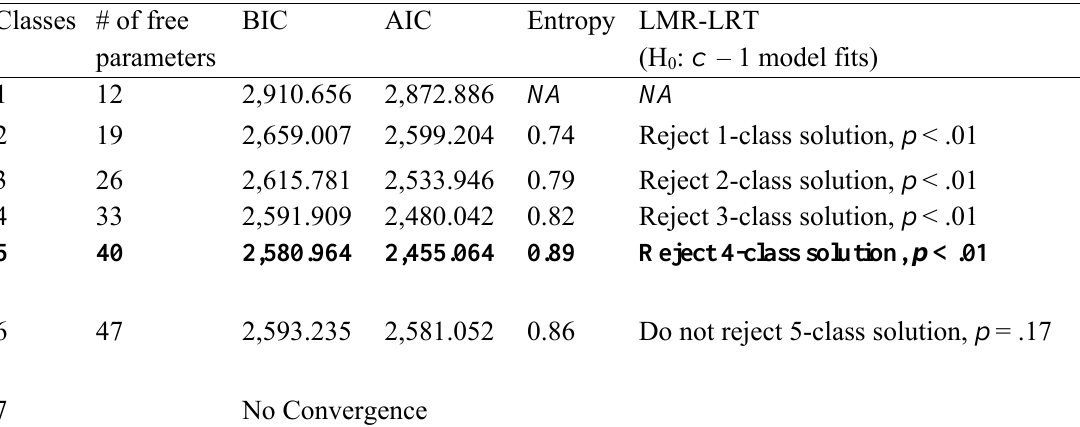
Study 2 Summary Statistics for Model Fit of Latent Class